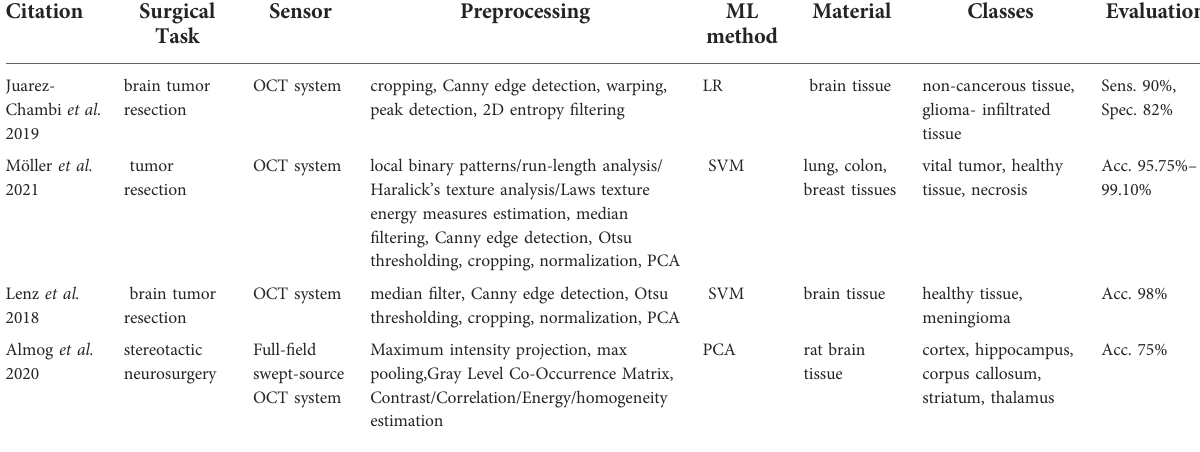
TABLE 7 General description of selected papers related to optical coherence tomography. Citation